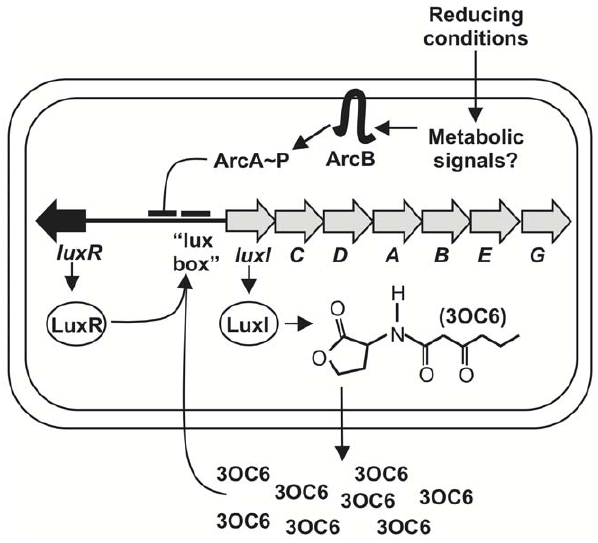
Figure 1. ArcA/ArcB and LuxR-LuxI-mediated regulation of bioluminescence in V.fischeri . LuxI synthesizes 3OC6, a diffusible pheromone that upon reaching a sufficient concentration combines with LuxR. 3OC6-LuxR binds to the ‘‘ lux box’’ and stimulates transcription of the luxICDABEG operon, which produces more 3OC6 and bioluminescence. The ArcA/ArcB two-component regulatory system responds to reducing conditions, and ArcA-P binds near the lux box, effectively inhibiting bioluminescence. Two other autoinducer pheromones AI-2 and C8-HSL are not shown, although the latter can also function with